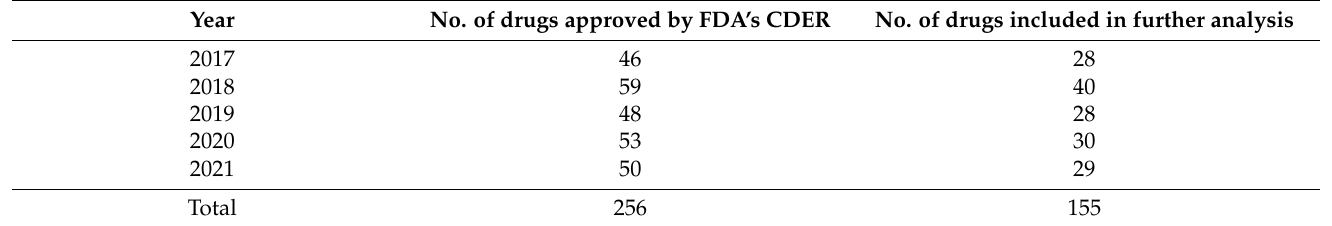
Figure 1. Workflow for the analysis using the drugs approved by FDA’s CDER between 2017 and 2021. F a , fraction absorbed; F g , intestinal availability; f u,p , unbound fraction of drugs in plasma; IC 50 , half maximal inhibitory concentration; k a , absorption rate constant; K i , inhibition constant, C max , maximum plasma concentration; R b , blood-to-plasma concentration ratio. Table 1. The number of drugs approved by FDA’s CDER between 2017 and 2021 and drugs included for analysis in this